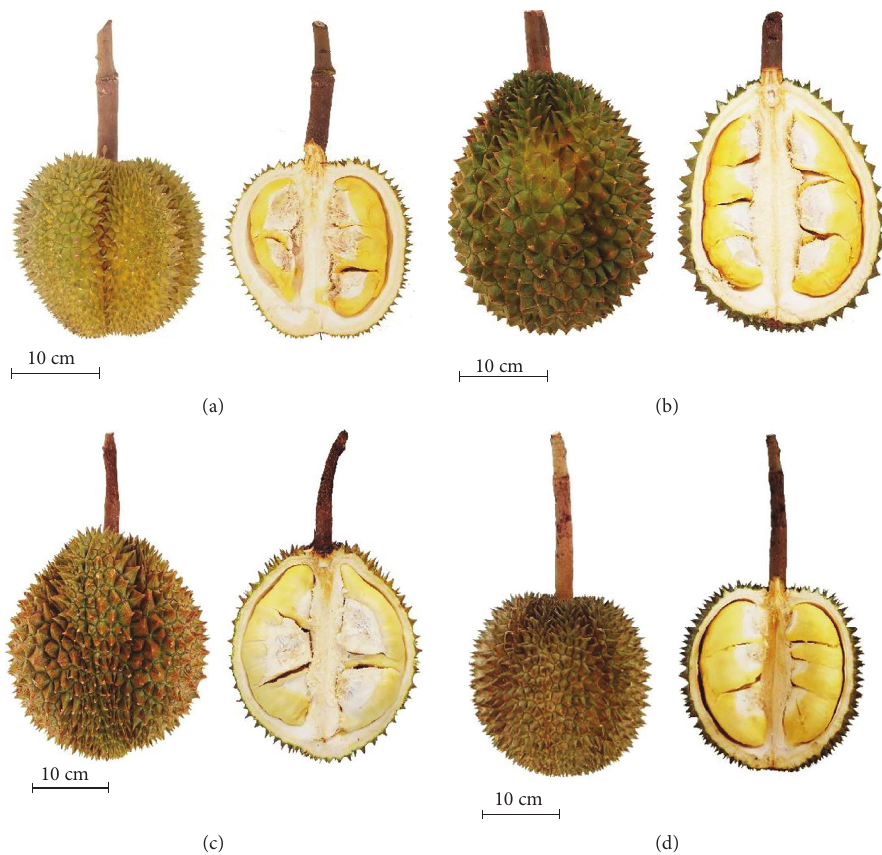
Figure 1: Appearances of the whole fruit (left) and flesh (right) of (a) “Chanthaburi 1,” (b) “Chanee,” (c) “Monthong,” and (d)